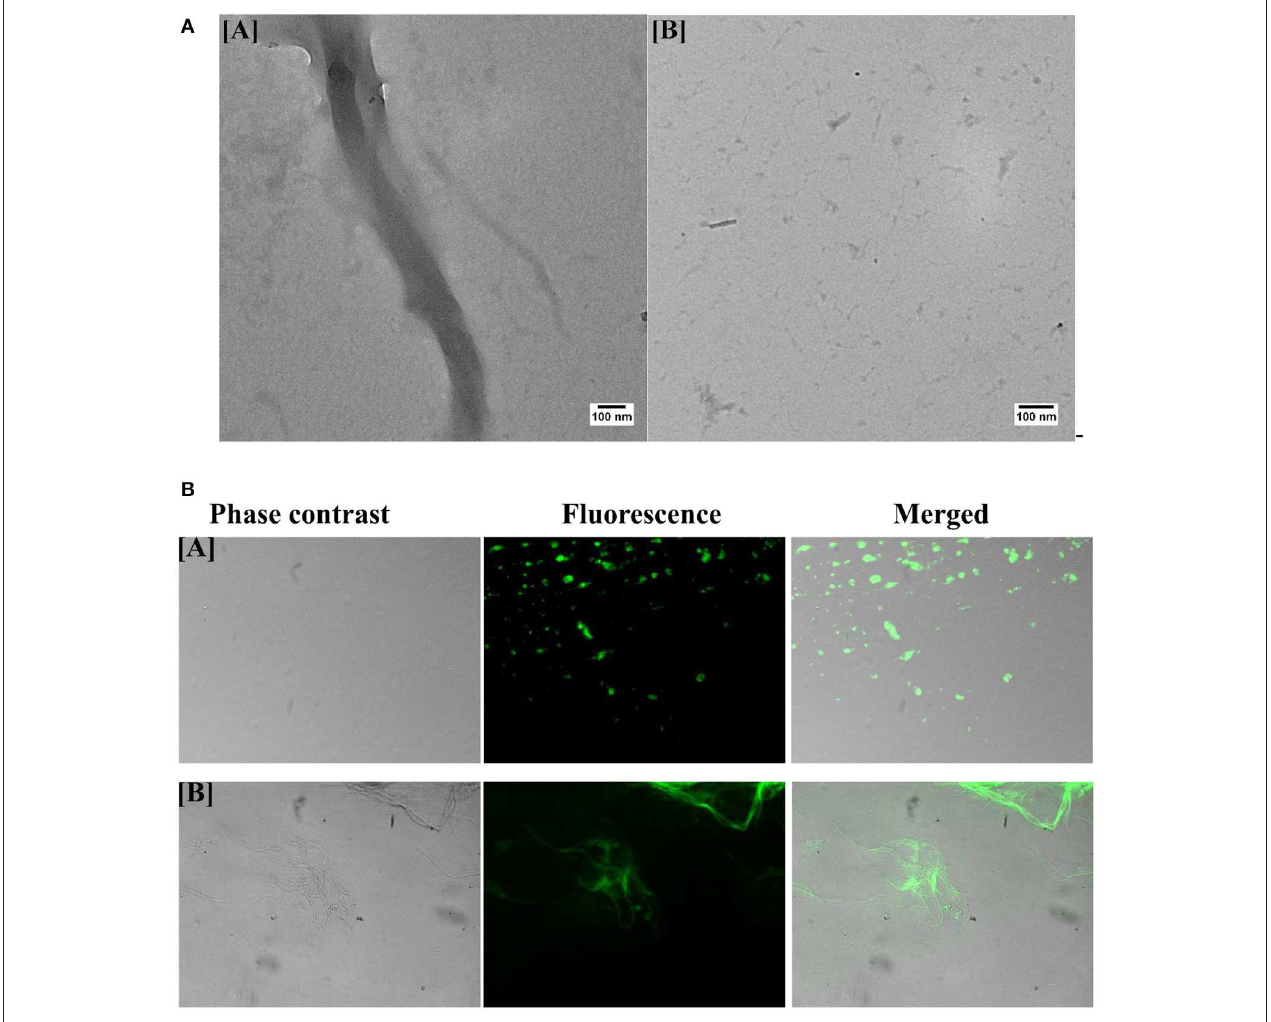
FIGURE 4 | (A) Transmission electron microscopy of as-synthesized OVA fibril prepared in the presence of B-AuNPs: [A] As- synthesized OVA amyloid. [B] Aggregation inhibition when amyloid synthesis was executed in presence of B-AuNPs. (B) Green fluorescence corresponding to ThT bound as-synthesized OVA Amyloid as visualized employing epifluorescence microscopy: The epi-fluorescence micrographs of the as-synthesized OVA amyloid formed in presence [A] or absence [B] of B-AuNPs.